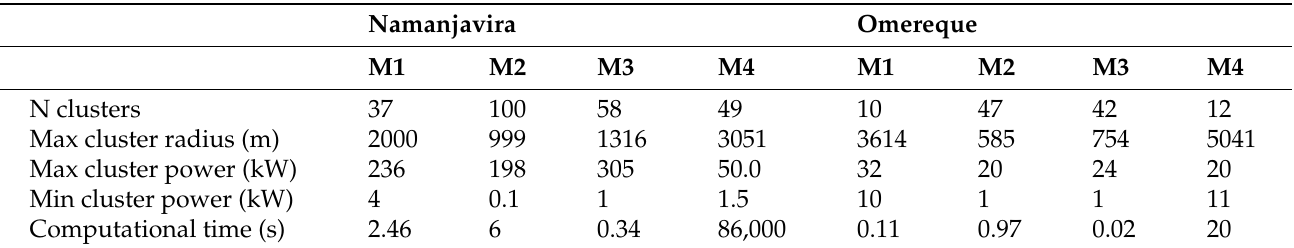
Table 3. Comparison of the